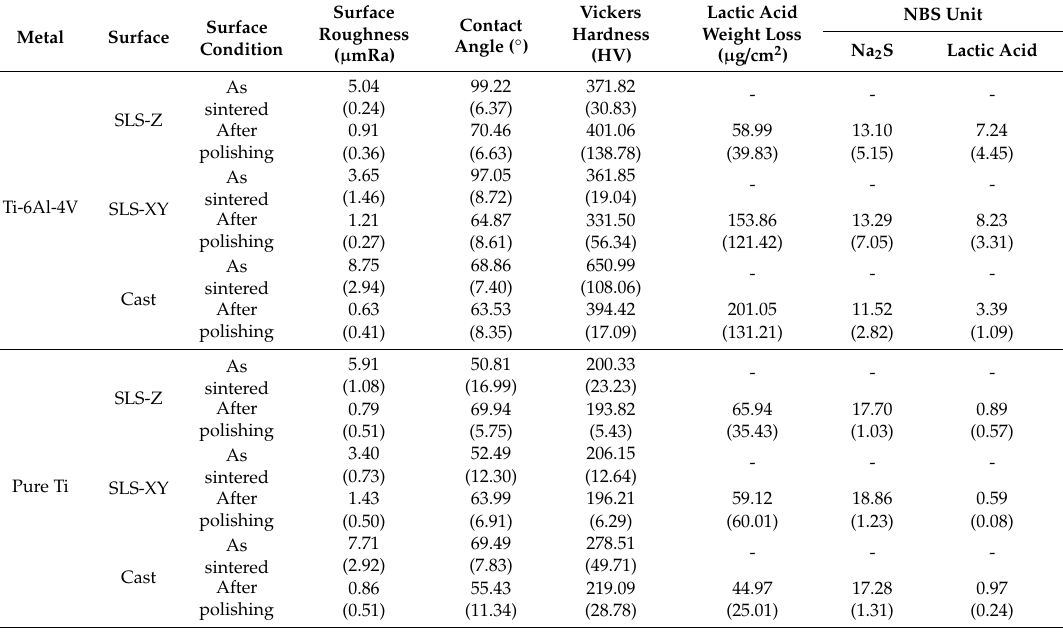
Standard deviations are given in